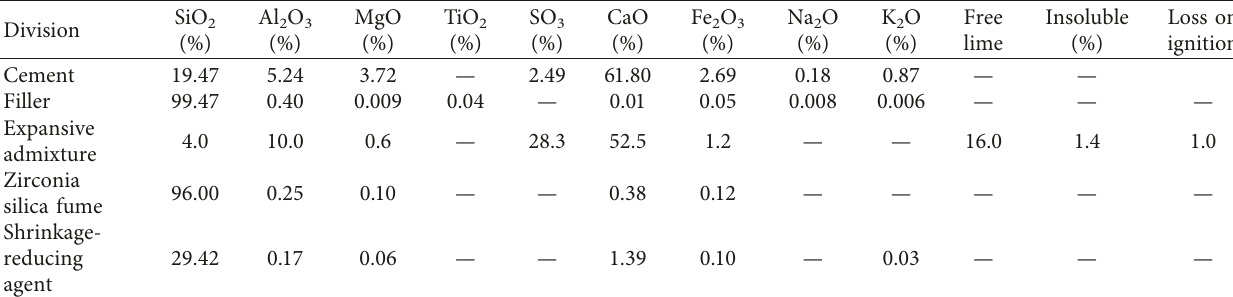
Table 3: Chemical composition of the binder.